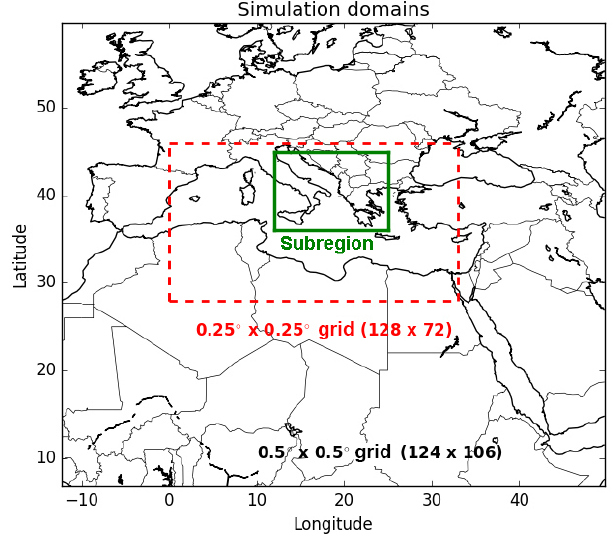
Figure 5. Simulation domains, including one large domain (with a 0.5 ◦ × 0.5 ◦ horizontal resolution) and a smaller domain (at a 0.25 ◦ × 0.25 ◦ horizontal resolution) delimited by the dotted red box. The subregion (Balkans, Greece, Eastern Europe and Italy) in- dicated in green box, is used in this